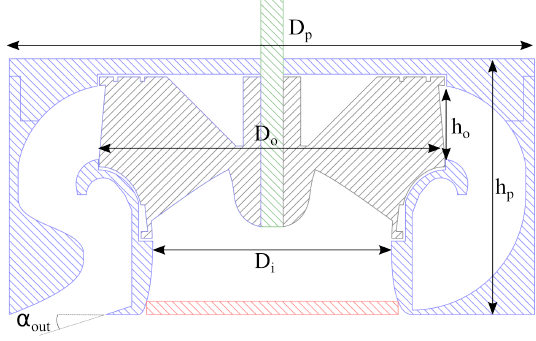
Figure 6. Schematic design of the PJM with the main characteristics.